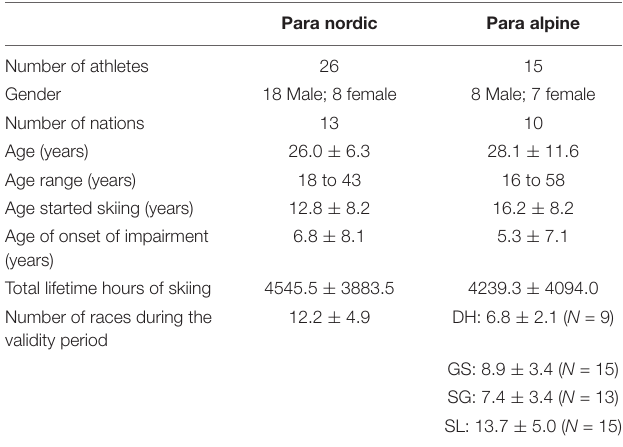
TABLE 1 | Participant details and summary statistics of their non-vision variables by